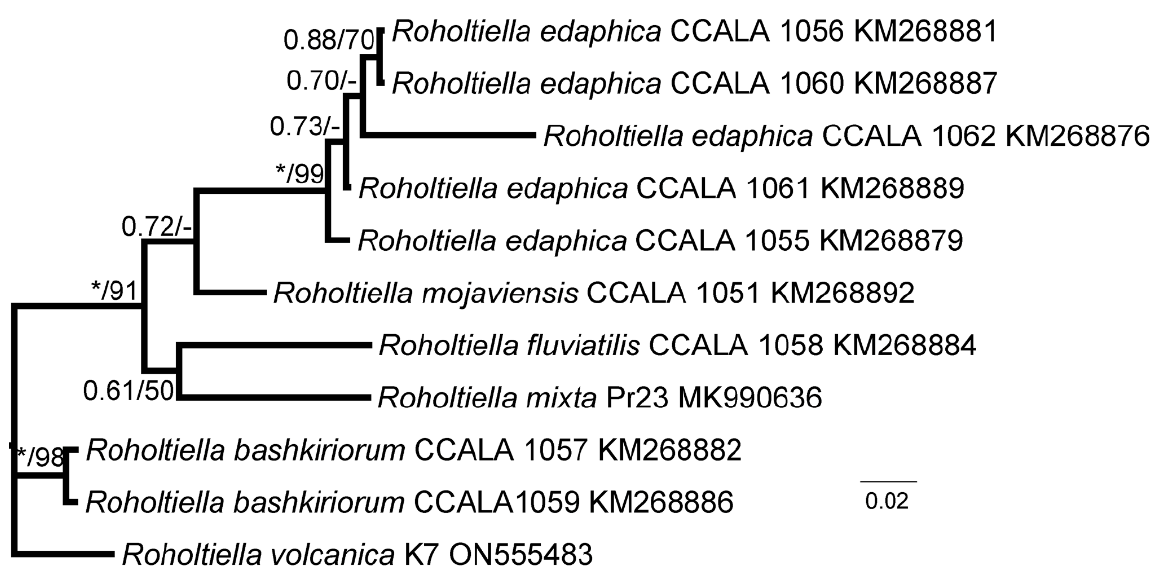
Figure 3. Phylogenetic positioning of Roholtiella volcanica K7 based on the 16S–23S ITS region of 11 cyanobacterial strains belonging to the genus Roholtiella , with the posterior probability/bootstrap values representing BI/MP mapped on to the nodes of the BI analysis. Posterior probabilities of 1.00 are indicated by an asterisk (*).